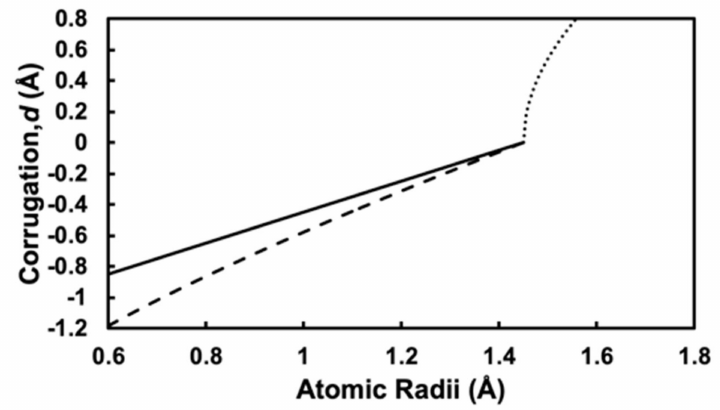
Figure 3. Simple hard spherical atomic model (SHSAM) for an M / Ag(111)– alloy. ( a ) Positive corrugation. ( b ) Side view of the negative corrugation case in the “monolayer model”. ( c ) Side view of the negative corrugation case in the “bilayer model”. The corrugation